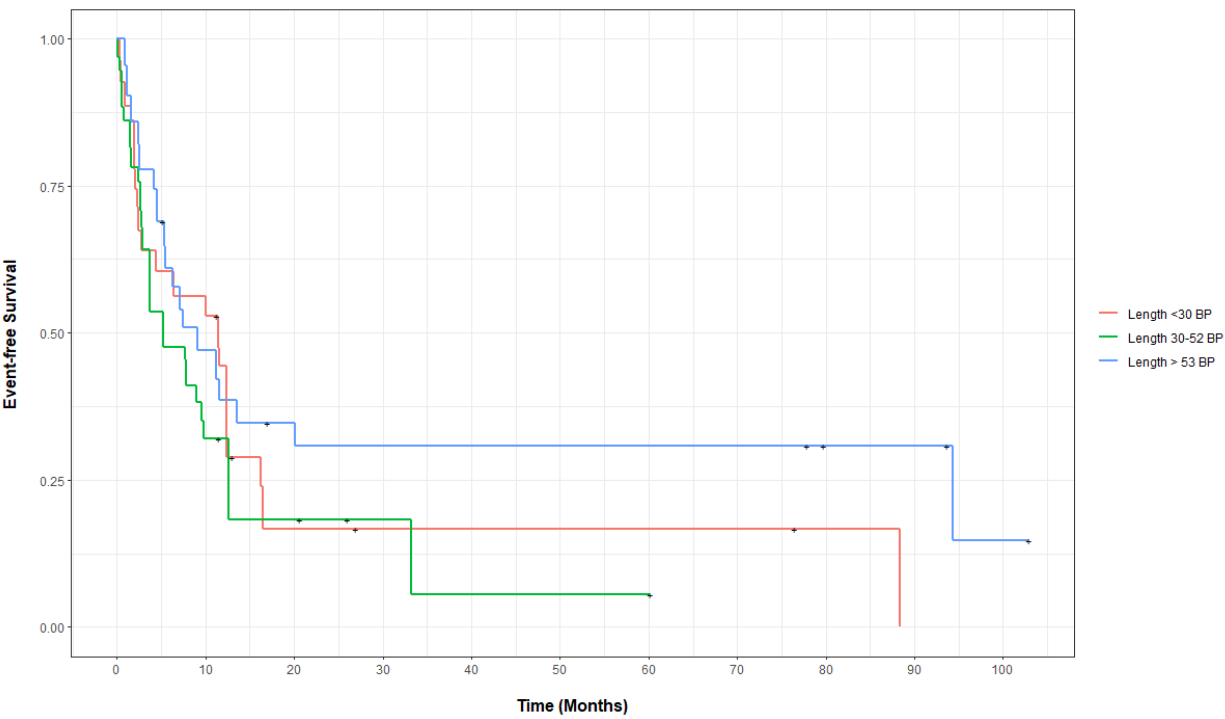
Figure 2. Propensity score ‐ adjusted event ‐ free survival for patients with FLT3 ‐ ITD ‐ mutated AML, categorized by insertion length.